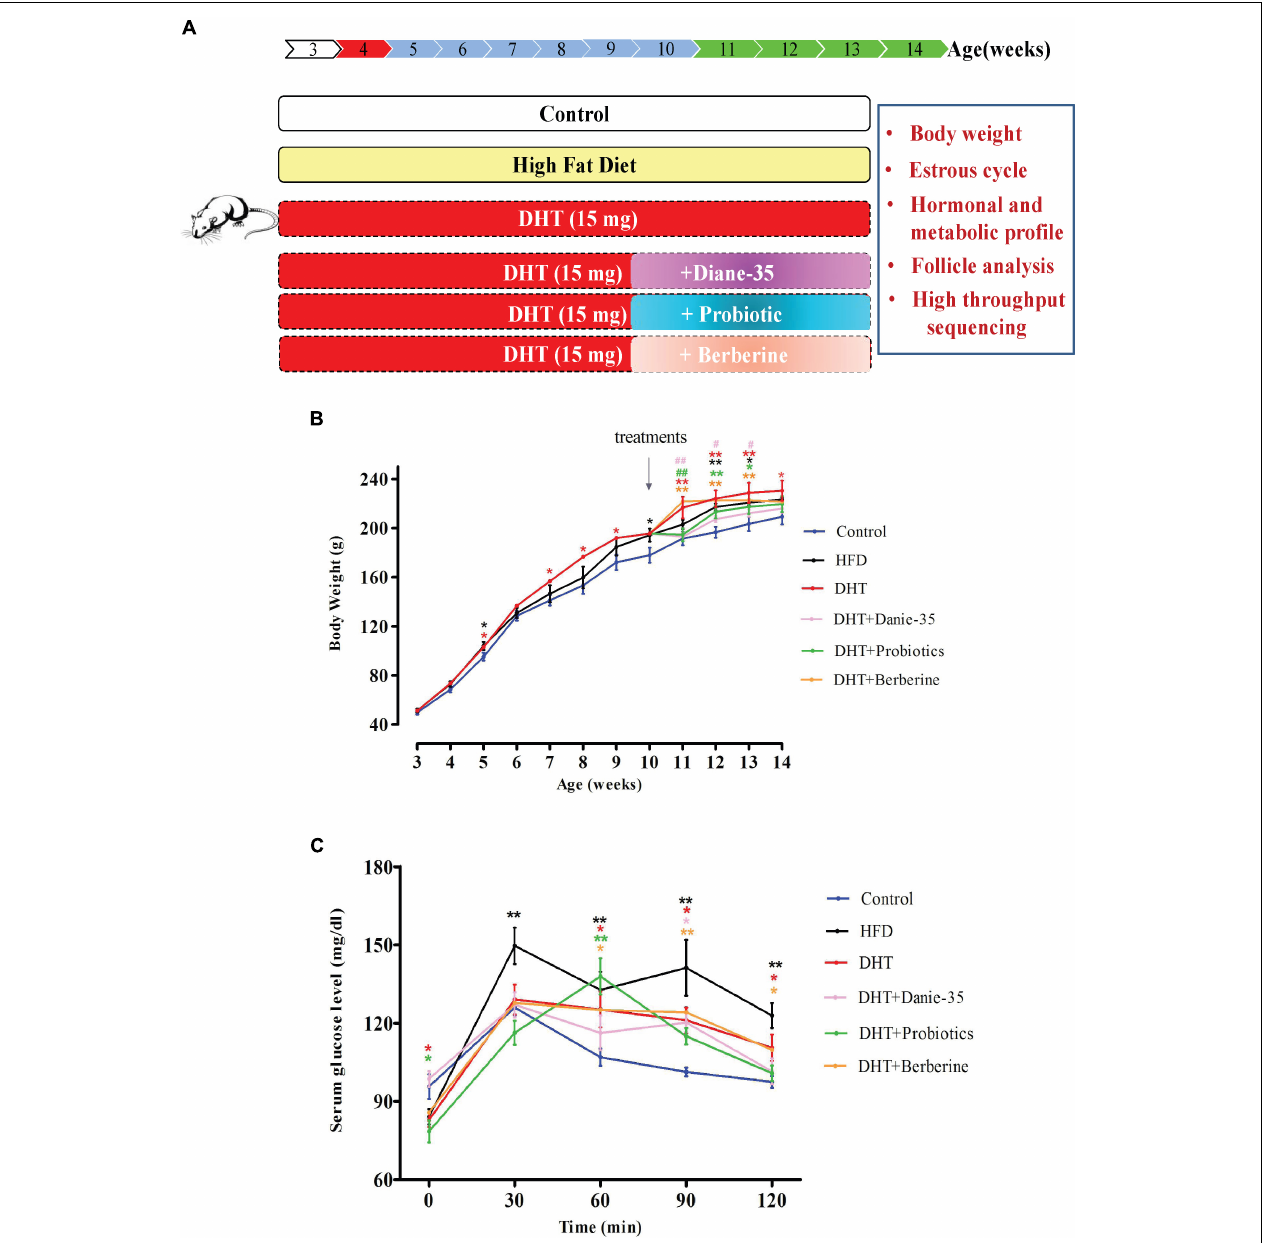
FIGURE 1 | (A) Schematic of animals and treatments. Wistar rats were randomly divided into six group as shown. The control rats received blank cervical silicone tubes subcutaneously at 21 days of age. The HFD group was fed a diet in which 60% of the calories came from fat daily throughout the whole experiment. At the same time, silicone tubes with DHT (15 mg, slow releasing for 75 days) were implanted subcutaneously into the neck in the DHT, DHT + Diane-35, DHT + Probiotics, and DHT + Berberine groups. The DHT-induced PCOS rats (at 7 weeks after implantation) received Diane-35 (0.005 ml/kg BW), probiotics ( Bifidobacterium triple viable, 210 mg/kg BW), or berberine (150 mg/kg BW) by intragastric administration. (B) Growth curves of rats from 21 days of age to 96 days of age. ∗ p < 0.05, ∗∗ p < 0.01 versus the control group and # p < 0.05, ## p < 0.01 versus the DHT group using two-way ANOVA and Tukey’s post hoc test. (C) Oral glucose tolerance test (OGTT). The basal blood glucose level was measured before being given the oral D -glucose (1.5 g/kg BW), and then measurements were made at 30, 60, 90, and 120 min. ∗ p < 0.05, ∗∗ p < 0.01 versus controls.